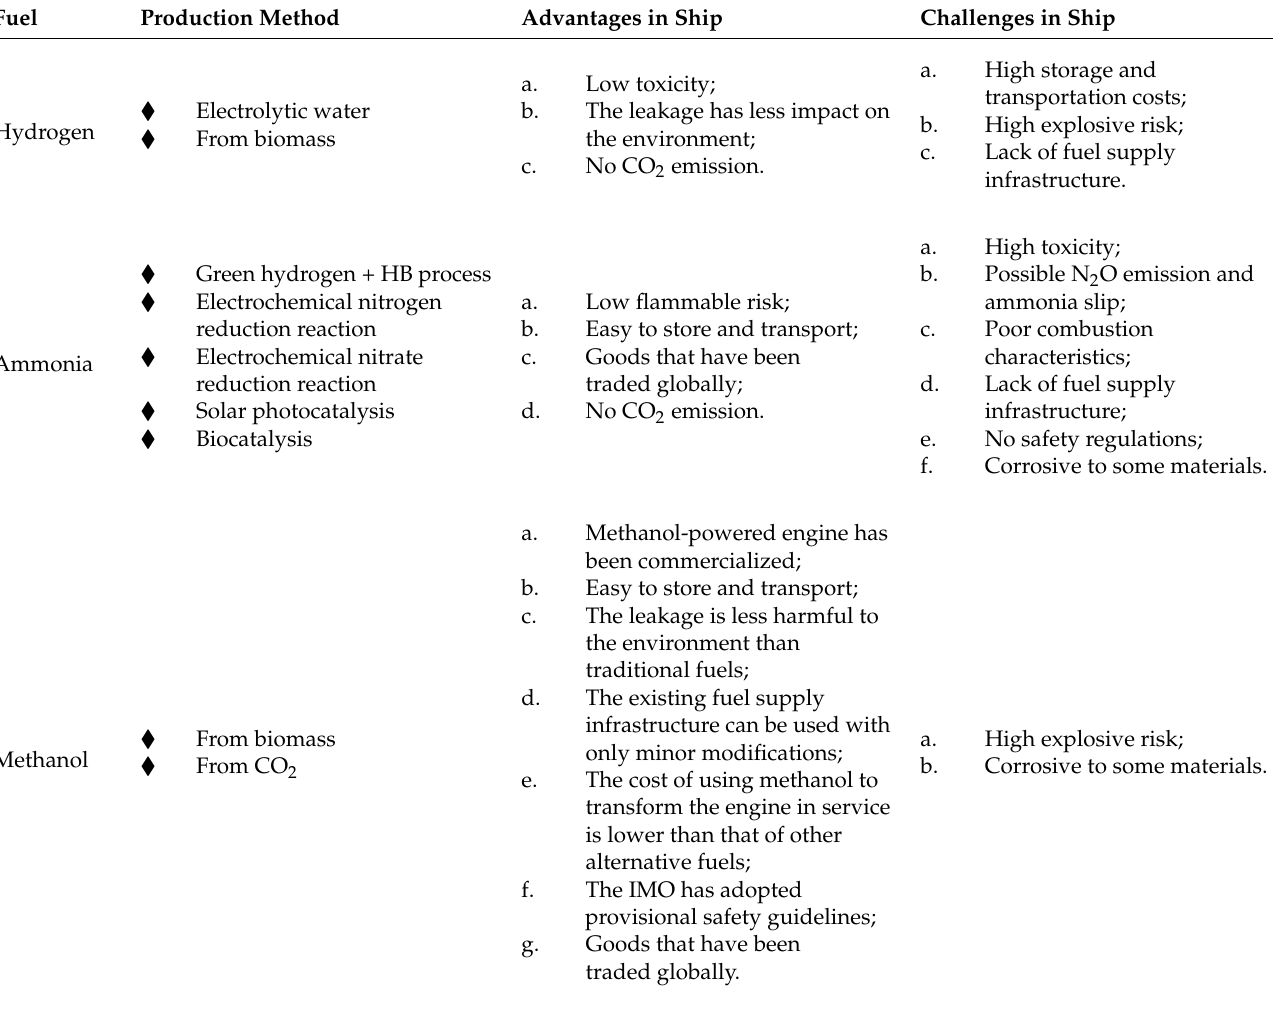
Table 2. Production methods of green hydrogen, green ammonia, and green